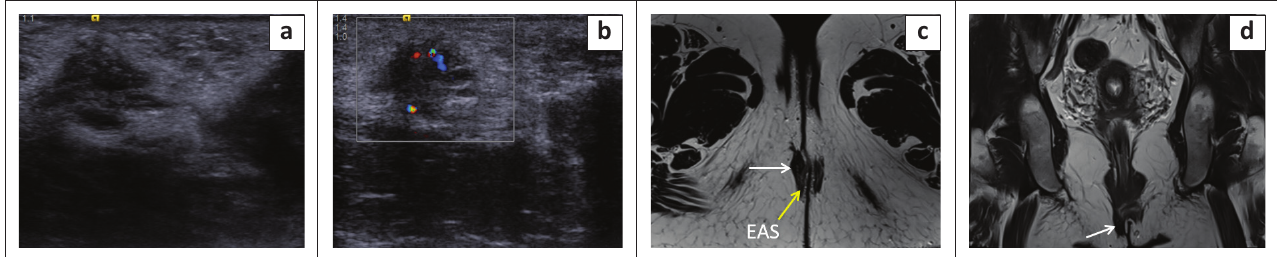
FIGURE 7: (a–d) Perineal scar endometriosis at the episiotomy site in a 33-year-old female with cyclical pain and swelling in the right vulval region. The ultrasound image (a) shows a stellate hypoechoic mass with internal vascularity (b) in the subcutaneous plane at the right vulva. Axial (c) and coronal (d) T2 W MR images show a predominantly T2 hypointense lesion (white arrows) abutting the external anal sphincter (external anal sphincter [EAS] – yellow arrow) posterosuperiorly with maintained fat planes.